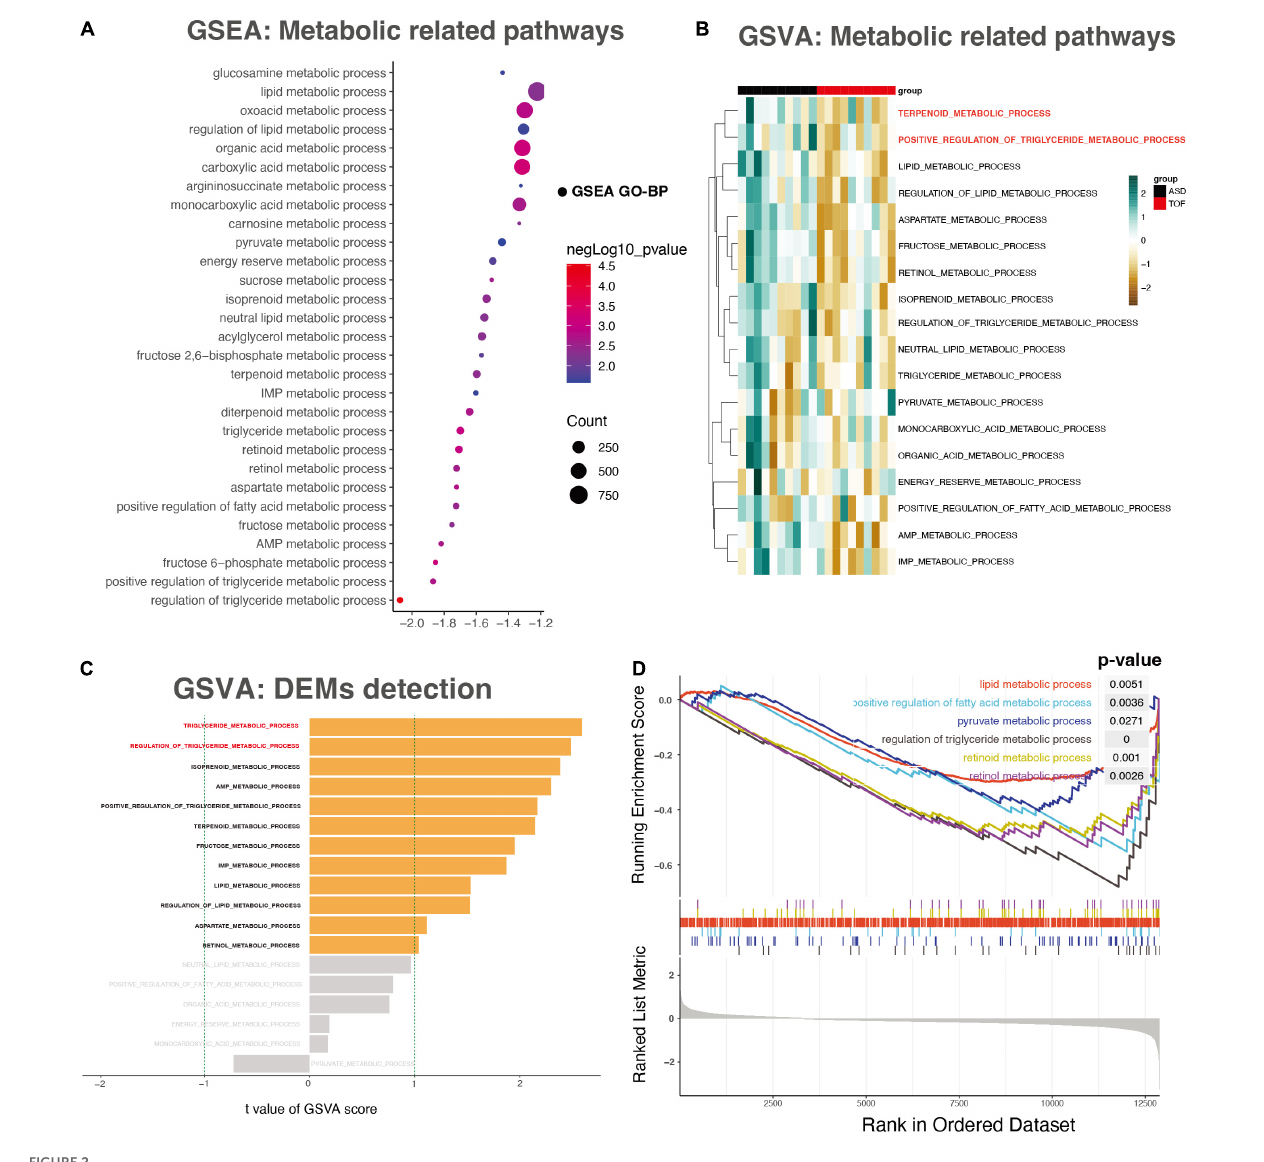
FIGURE2 Gene set enrichment analysis (GSEA) and gene set variation analysis (GSVA). (A) The energy metabolism-related pathways detected through GSEA analysis. (B) The heatmap of the GSVA score for the KEGG pathway. (C) The bar plot for patterns of the GSVA score of energy metabolism. (D) The energy metabolism- related pathways detected through GSEA